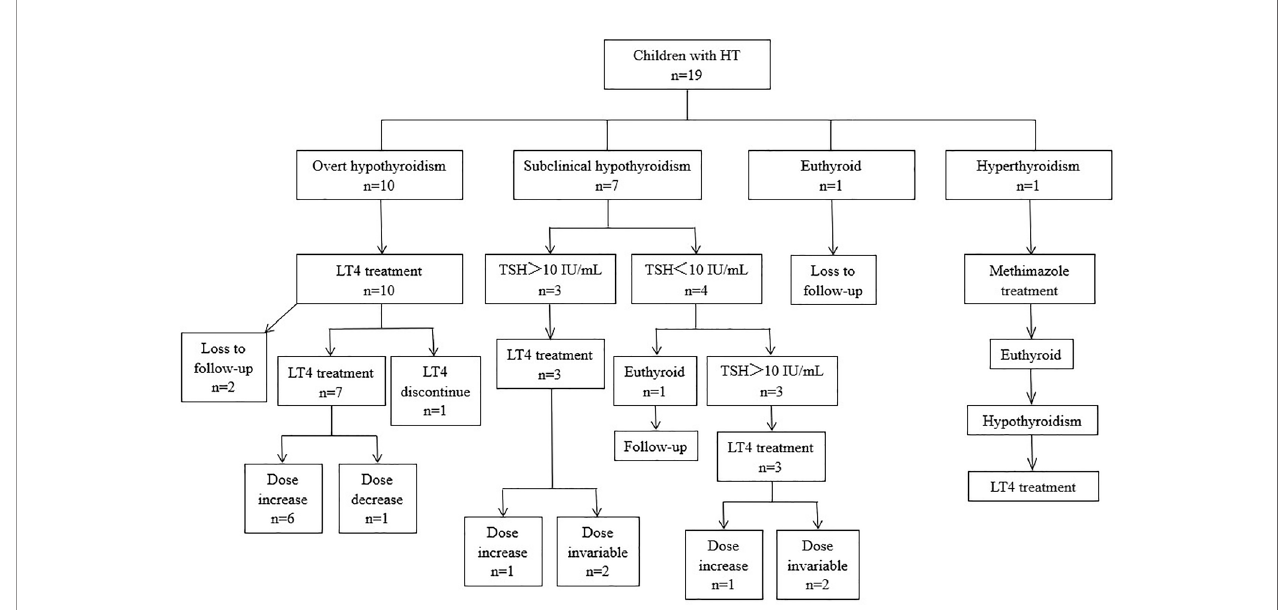
FIGURE 1 | Thyroid function at presentation, treatment, and clinical courses of 19 children with HT. LT4, L-thyroxin; TSH, thyroid-stimulating